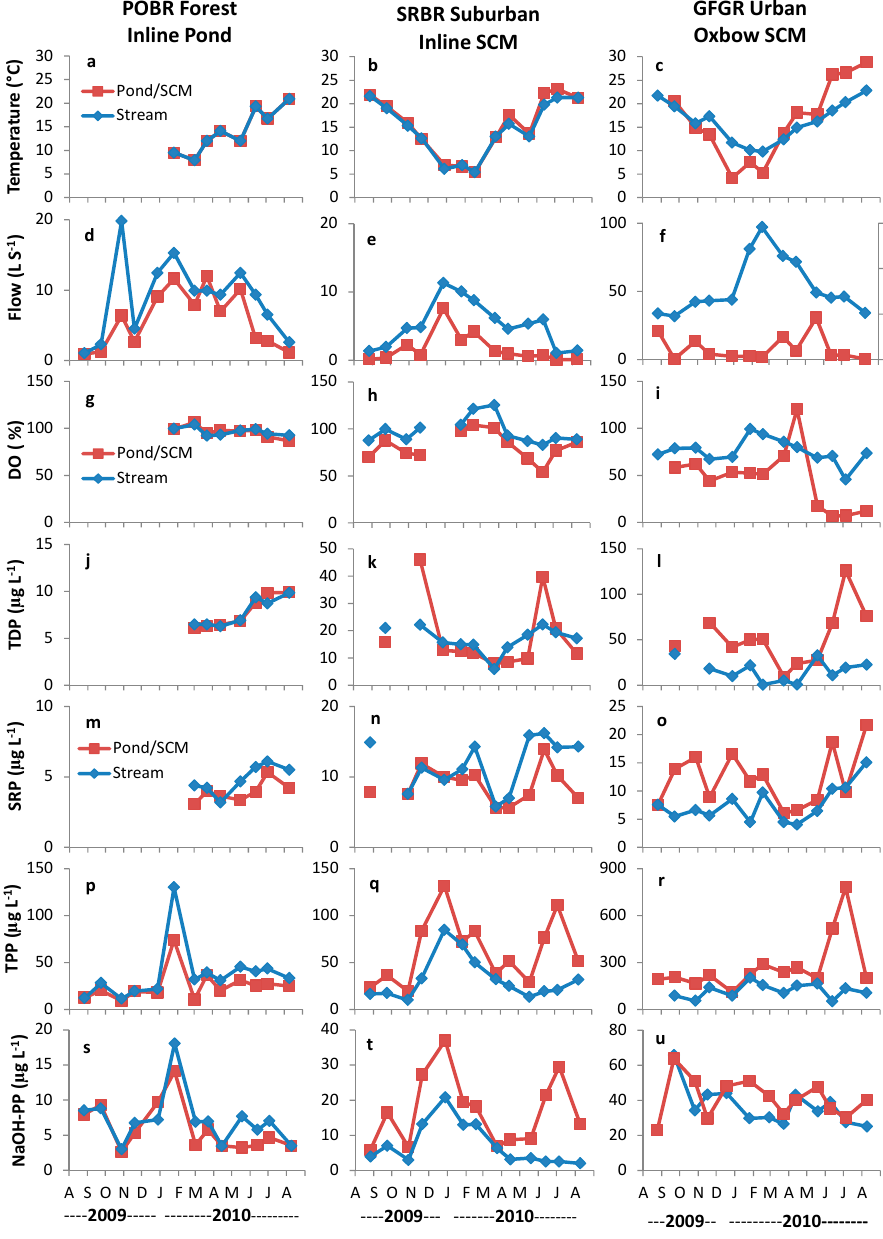
Figure 3. Monthly changes in ( a )–( c ) water temperature; ( d )–( f ) flow; ( g )–( i ) dissolved oxygen saturation (%DO), and concentrations of ( j )–( l ) total dissolved P (TDP); ( m )–( o ) soluble reactive P (SRP); ( p )–( r ) total particulate phosphorus (PP) and ( s )–( u ) NaOH extractable PP (NaOH ‐ PP) at the pond/SCMs outlets and adjacent free ‐ flowing stream reaches. Capital letters on x ‐ axis are the first letter of months representing months of the two years in a chronological sequence. Data of water temperature, DO, TDP and SRP of the forest inline pond were not collected during April–July 2009.